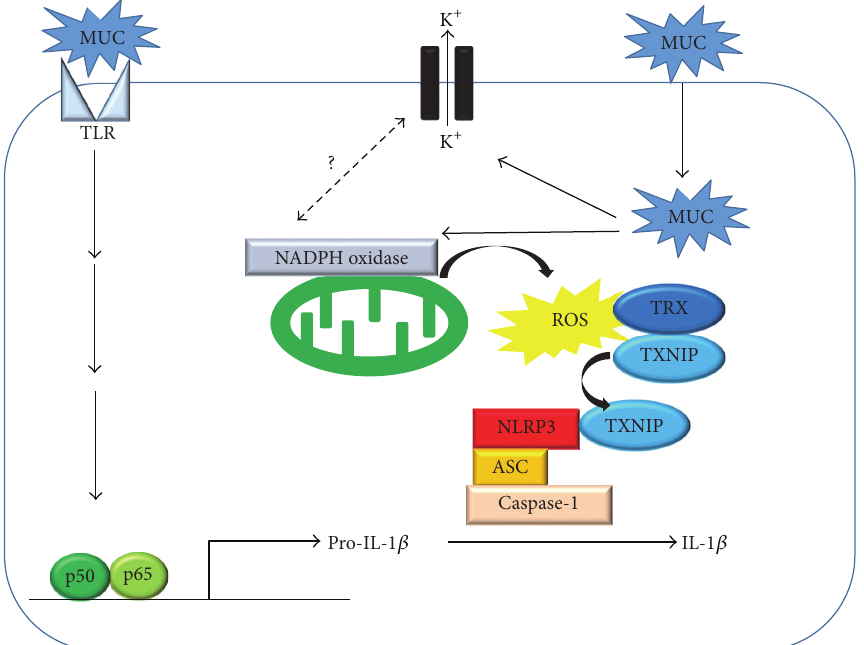
Figure 2: MUC induces inflammasome activation. MUC activates the NF- 𝜅 B pathway through TLR2/4, thereby increasing the expressions of pro-IL-1 𝛽 or pro-IL-18. At the same time, MUC induces ROS release from mitochondria. The generated ROS detaches TXNIP from thioredoxin and enables TXNIP to interact with the NLRP3 complex. The binding of TXNIP to NLRP3 activates inflammasomes, leading to the production of mature IL-1 𝛽 or IL-18. MUC: monosodium urate crystals, TLR: Toll-like receptor, TXNIP: thioredoxin-interacting protein, TXR: thioredoxin, and ROS: reactive oxygen